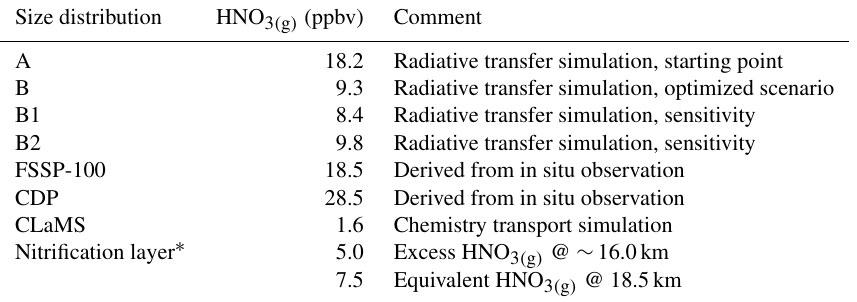
Table 3. Comparison of equivalent HNO 3 ( g ) corresponding to the particle size distributions used in the radiative transfer simulations of the MIPAS-STR observations, the size distributions derived from the in situ measurements, and a CLaMS simulation, together with excess HNO 3 ( g ) derived for the nitrification layer below the observed